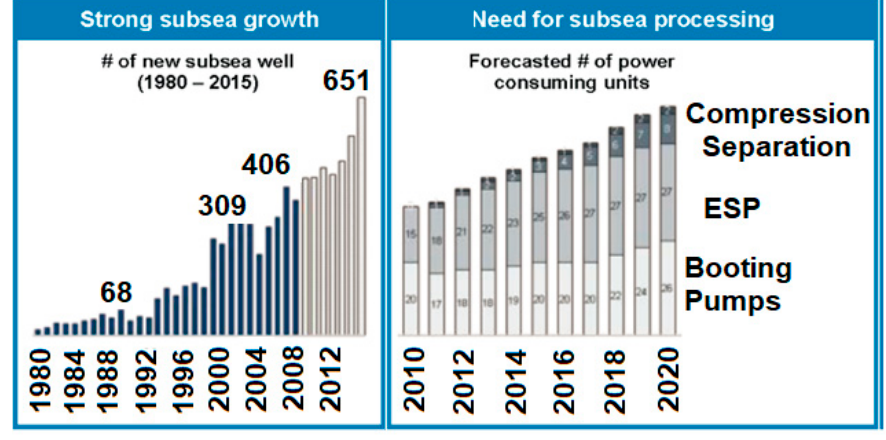
Figure 1. Subsea oil and gas growth.